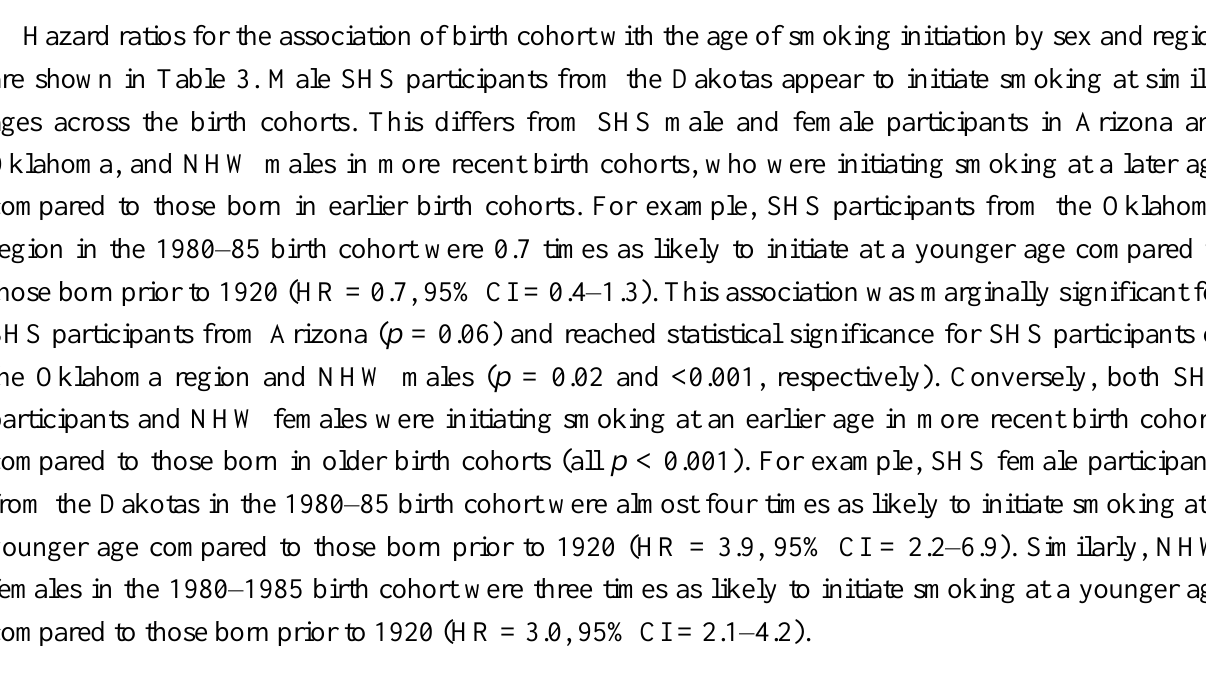
Table 3. Hazard ratios (HRs) for smoking initiation by age 18 years or younger according to sex in Strong Heart Study (SHS) and National Health Interview Survey (NHIS)